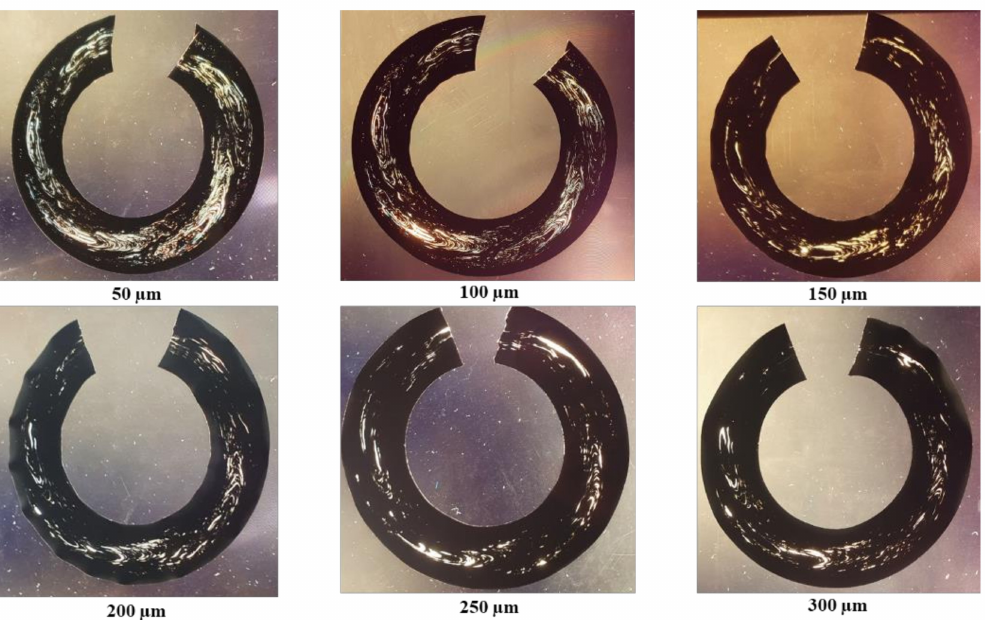
Figure 7. Windows’ observation of the whole pipe cross sections in shavings of different thicknesses under cross-polarized monochromatic light.